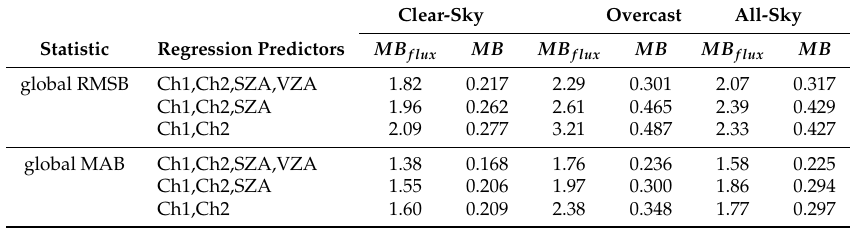
Table 8. Global accuracy statistics from bias map, based on surface-type-dependent regressions from expanded database (with relaxed matching criteria) for clear, overcast, and allsky conditions; Data: 2004–2005 (NOAA17+Terra), 2007–2008 (NOAA18+Aqua) and 2011–2012 (NOAA19+Aqua). Clear-Sky Overcast All-Sky Statistic Regression Predictors MB flux MB MB flux MB MB flux MB global RMSB Ch1,Ch2,SZA,VZA 1.82 0.217 2.29 0.301 2.07 0.317 Ch1,Ch2,SZA 1.96 0.262 2.61 0.465 2.39 0.429 Ch1,Ch2 2.09 0.277 3.21 0.487 2.33 0.427 global MAB Ch1,Ch2,SZA,VZA 1.38 0.168 1.76 0.236 1.58 0.225 Ch1,Ch2,SZA 1.55 0.206 1.97 0.300 1.86 0.294 Ch1,Ch2 1.60 0.209 2.38 0.348 1.77